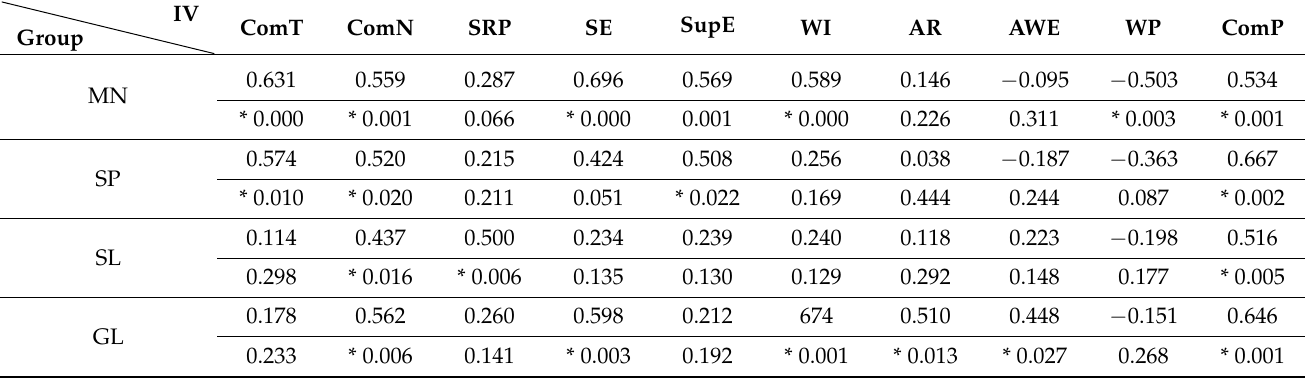
Table 3. Pearson Correlation ( r -value) and Significance of IVs ( p -value) by Group.